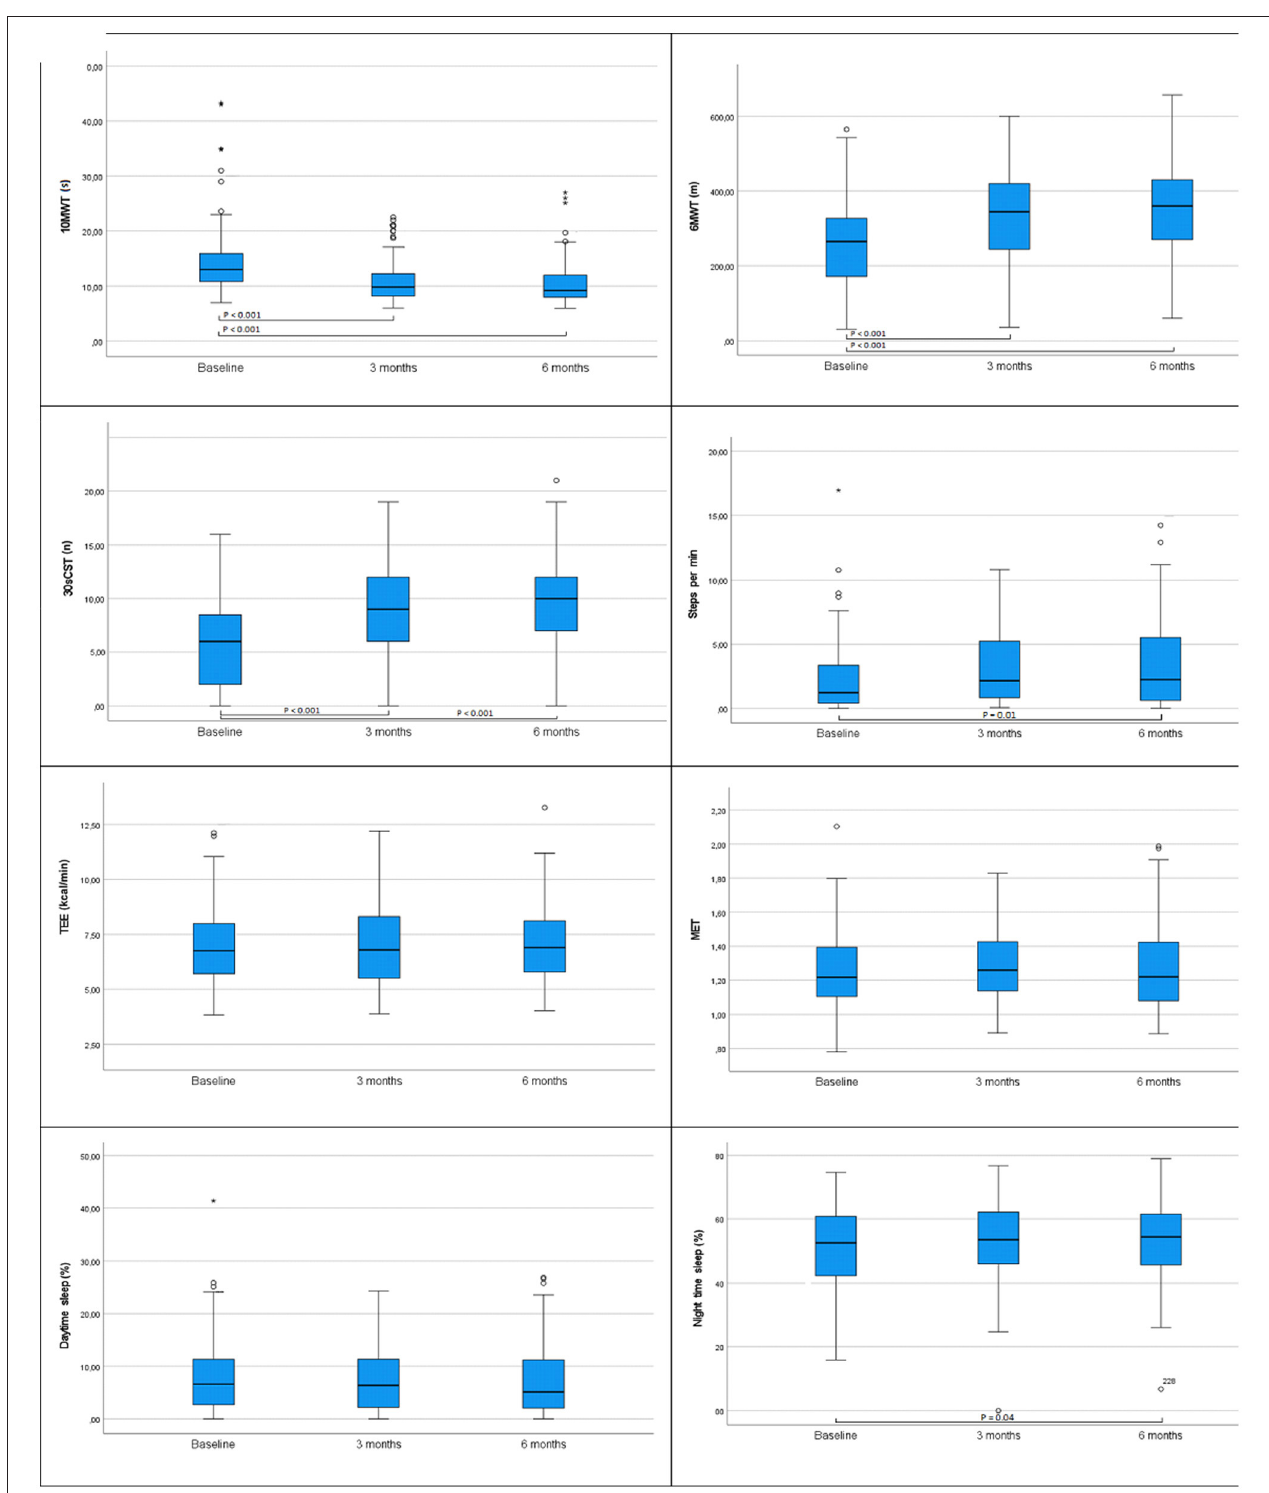
FIGURE 2 | Values at baseline, 3 and 6 months postoperatively for the variables in all patients: 10-m walk test (10MWT), 6-min walk test (6MWT), 30-s chair stand test (30sCST), total energy expenditure (TEE), metabolic equivalent of task (MET), daytime sleep, and nighttime sleep. Significant differences are presented in the figures, p ≤ 0.05. Differences were tested with related samples Friedmans two-way analysis of variance (ANOVA) by ranks. Significance values are adjusted by the Bonferroni correction for multiple tests. N = 109. In the figure of 10MWT, two extreme values are excluded.